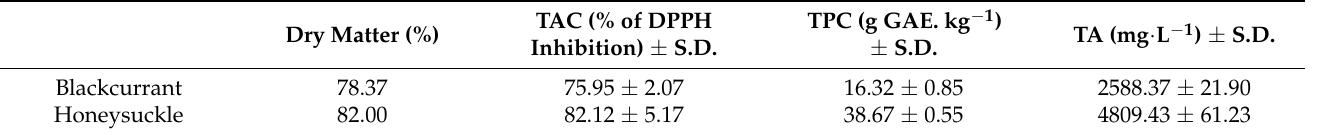
Table 2. Selected chemical characteristics of plant extracts (expressed as value ± standard